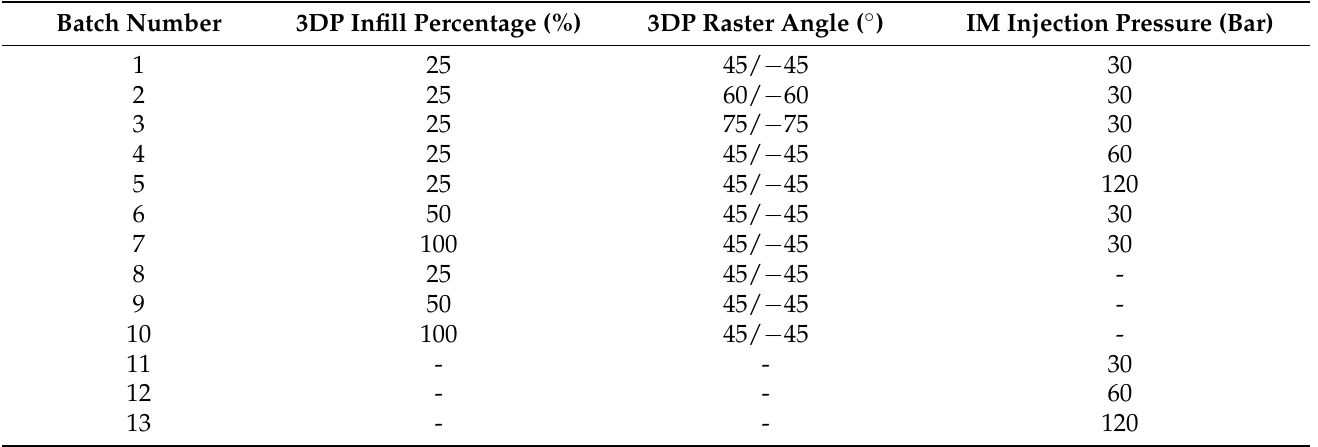
Table 3. The parameters of injection molding and overprinting process.